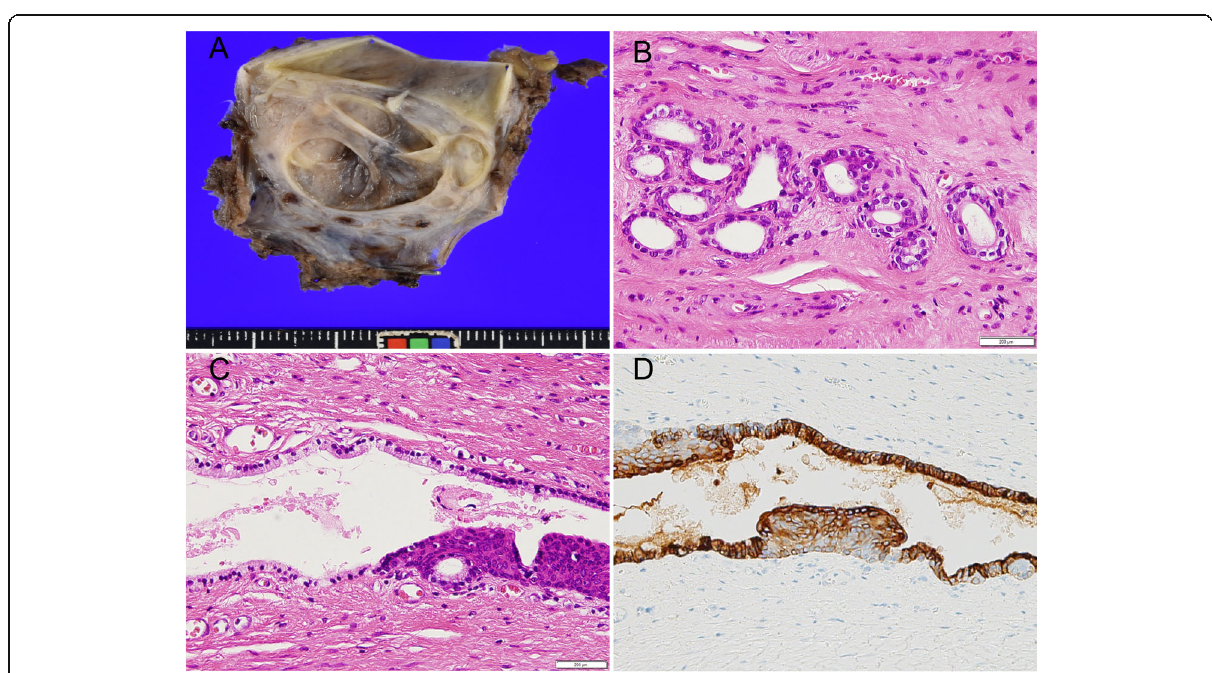
Fig. 5 Histopathology. a Macroscopically, the tumor measures 43 × 35 × 10 mm and contains multiple cysts of different sizes. b The inner surfaces of the cysts are smooth and even (hematoxylin and eosin [HE] × 100). c The cyst walls are lined by eccrine sweat glands (HE × 200). d Immunostaining shows S100-positive myoepithelial cell-like cells (×